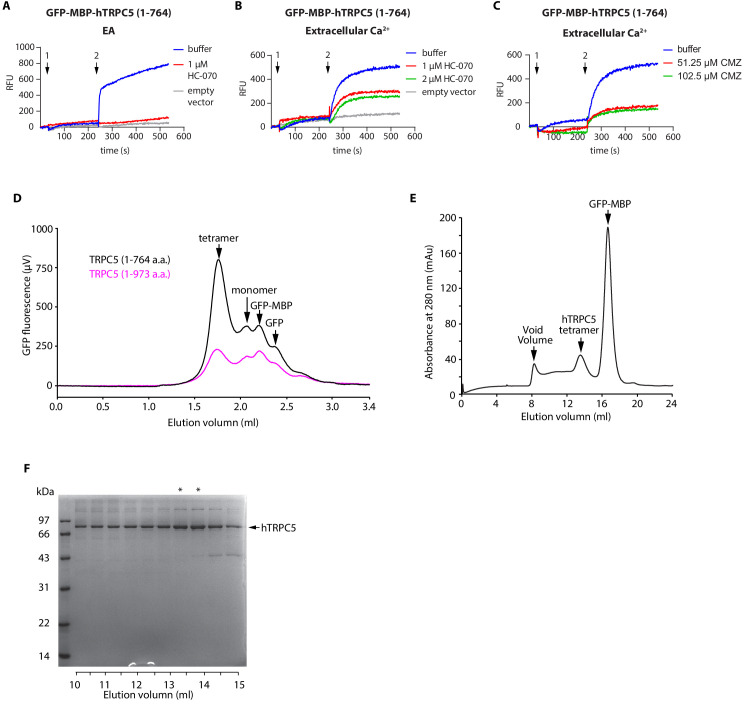
Biochemical and functional characterization of human TRPC5 (hTRPC5) constructs.(A–C) Representative intracellular calcium signal of AD293 cells transfected with hTRPC5(1-764) evoked by 256 nM EA (A) or 14 mM extracellular calcium (B, C), and inhibited by different concentrations of HC-070 (B) or clemizole (CMZ) (C), measured by FLIPR calcium assay. Arrow 1 denotes the time point for application of buffer alone or buffer with inhibitors; arrow 2 denotes the time point for application of the activators. (D) Fluorescence size exclusion chromatography profile of full-length hTRPC5 and hTRPC5(1-764). (E) Representative size exclusion chromatography of hTRPC5(1-764) purified in glycol-diosgenin (GDN) micelles. (F) SDS-PAGE gel of hTRPC5(1-764) eluted from size exclusion chromatography. The position of TRPC5 is labeled. Fractions that were pooled for cryo-EM analysis are denoted by asterisks.